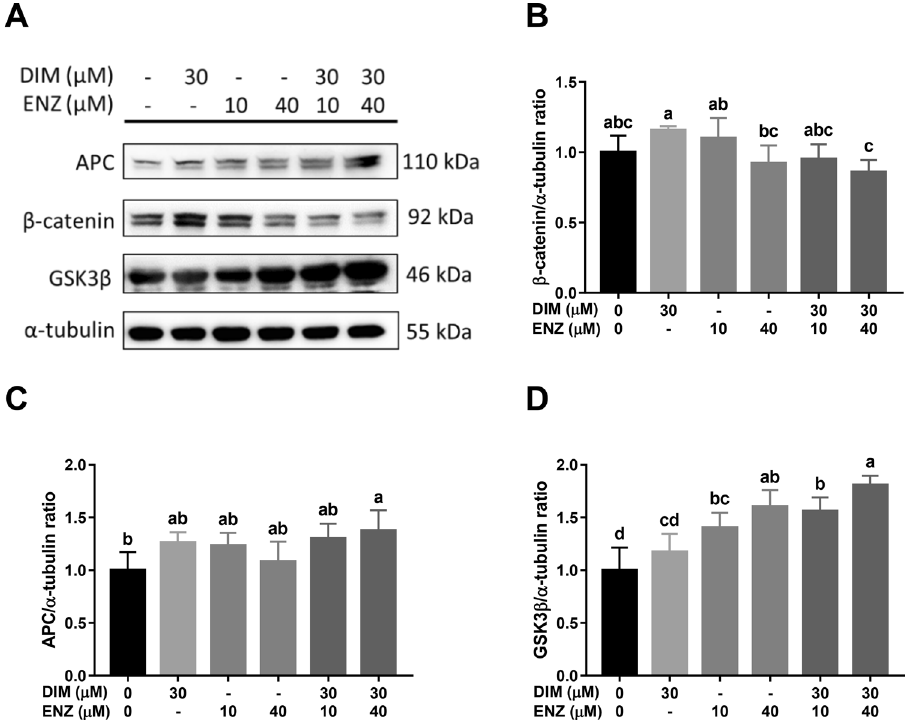
Figure 6. Inhibition of Wnt signaling by DIM and ENZ co-treatment in 22Rv1 cells at 72 h. Representative western blot image ( A ); quantitative results for β-catenin ( B ), APC ( C ), and GSK3β ( D ). DIM 3,3 ′ -diindolylmethane; ENZ enzalutamide. a,b,c,d Bars without the same letters at the top indicate statistically- significant differences between treatments when compared with each other (one-way ANOVA, Duncan’s new multiple range test, p <